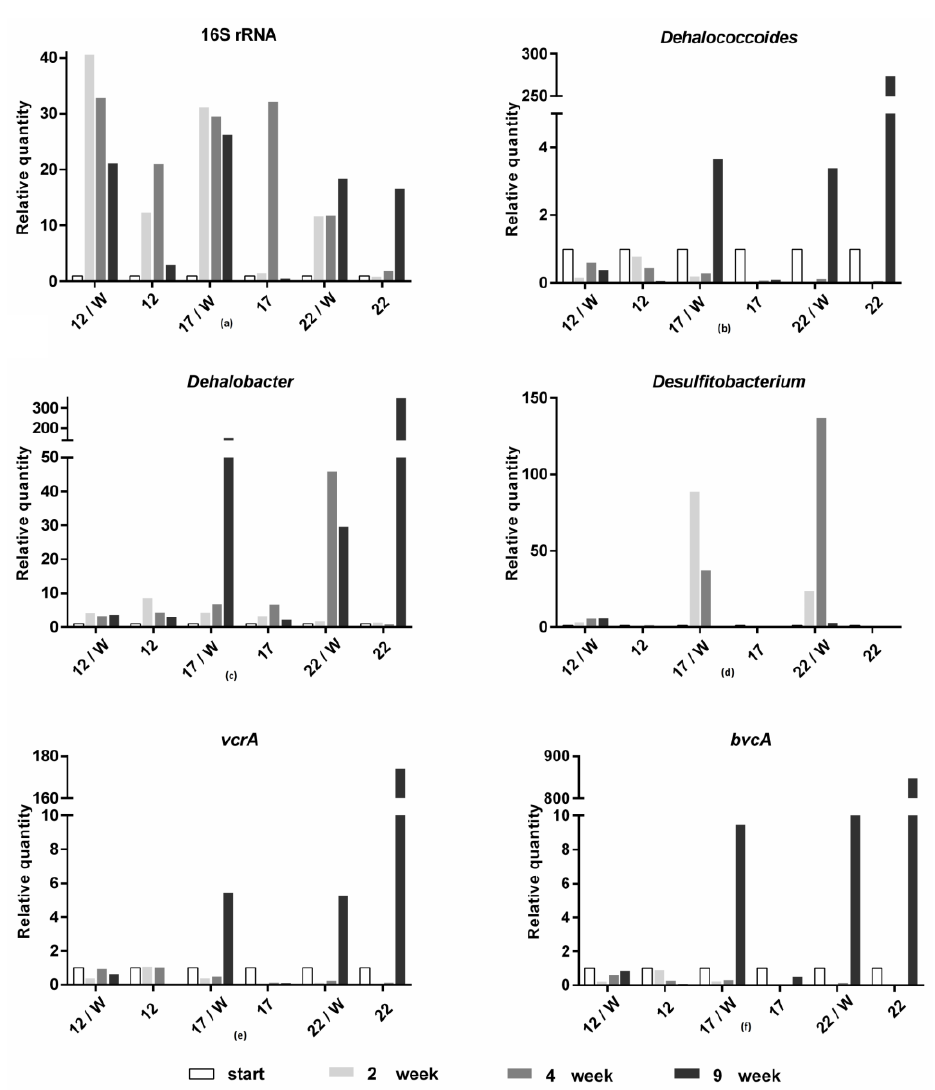
Figure 6. Abundance changes in the bacterial biomass ( a ); representatives of dechlorinating bacteria Dehalococcoides spp. ( b ), Dehalobacter spp. ( c ), and Desulfitobacterium spp. ( d ); vinyl chloride reductase genes vcrA ( e ) and bvcA ( f ) at different temperatures with and without whey addition.